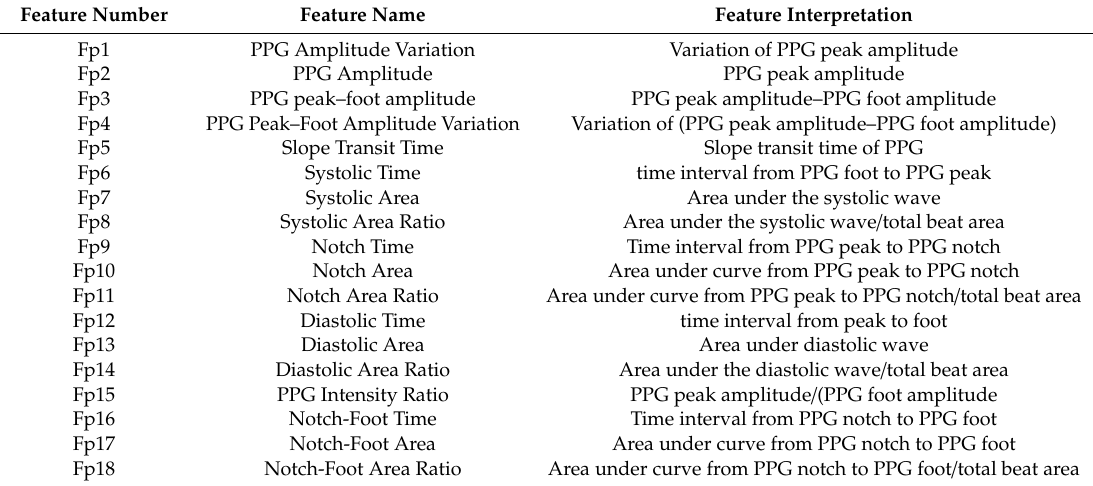
Table A2. PPG-waveform-derived